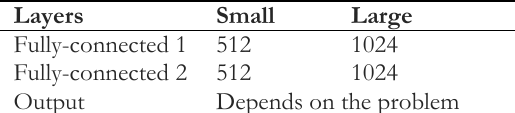
Table 1. Fully connected layers in this experiment.